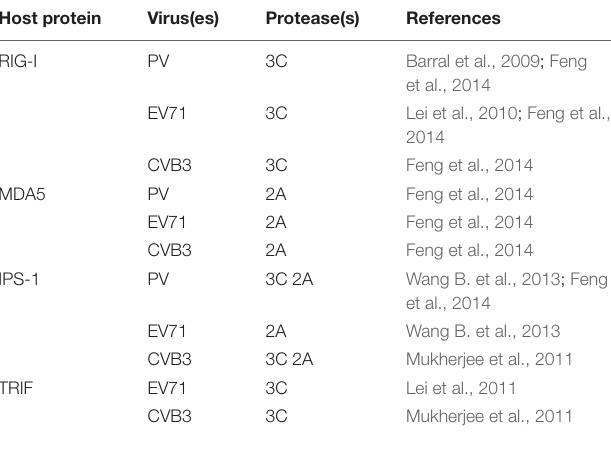
TABLE 1 | Host proteins cleaved by enterovirus protease(s) during inhibition of